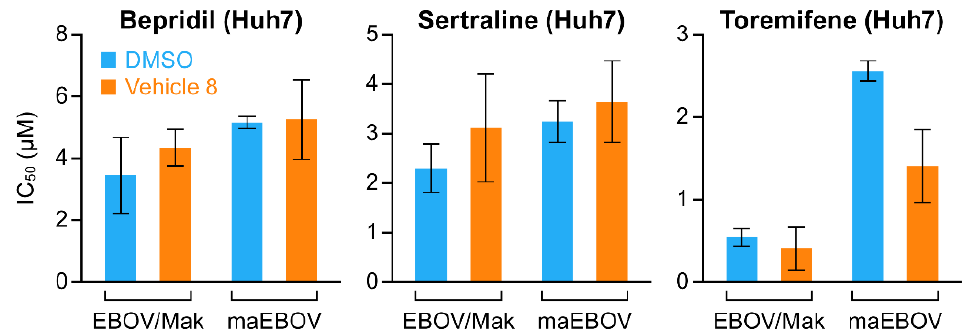
Figure 4. Activity of bepridil, sertraline and toremifene in DMSO and V8 against EBOV/Mak and ma-EBOV. Drug treatments and infections were conducted as described in the Methods section and legend to Figure 3. The data shown are the average IC 50 s +/ − sd from four plates excepting one plate with Z’ factor <0.2.